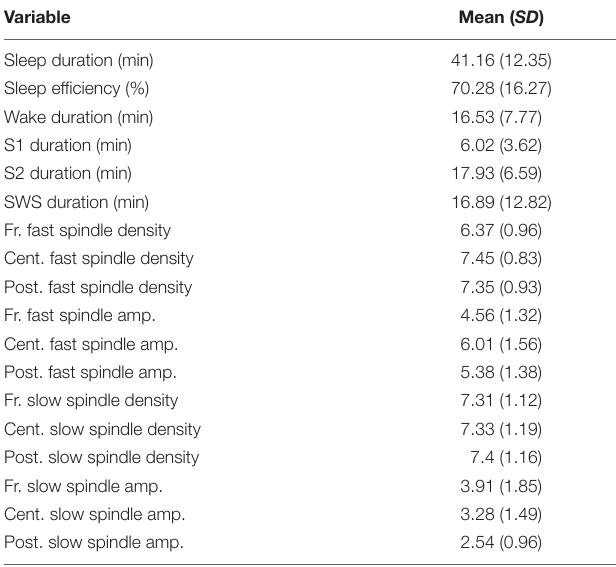
TABLE 2 | Descriptive characteristics of sleep parameters in the Nap